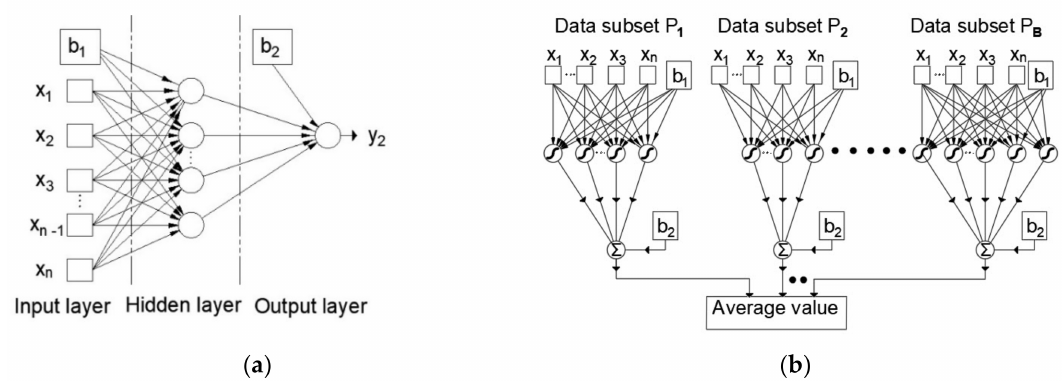
Figure 1. ( a ) Multilayer perceptron artificial neural network; ( b ) an ensemble of neural networks formed by the Bootstrap Aggregating (Bagging) approach